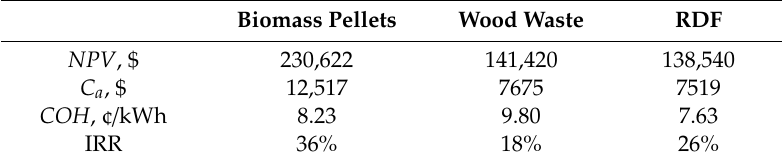
Table 7. Economic analysis conclusion for the system under di ff erent fuel